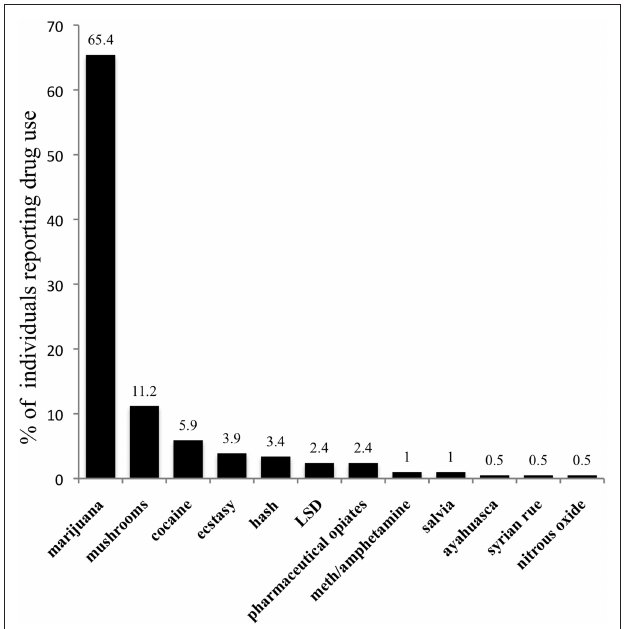
Figure 1 | recreational drug use reported by 204 undergraduate students on the DuQ.